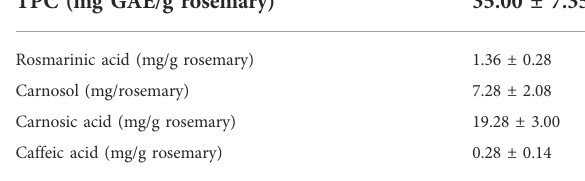
TABLE 3 Results of the TPC in mg GAE/g rosemary and for the rosmarinic acid, carnosol, carnosic acid, and caffeic acid in mg/g rosemary for the extract obtained with methanol. Data are expressed as mean ± SD. TPC (mg GAE/g